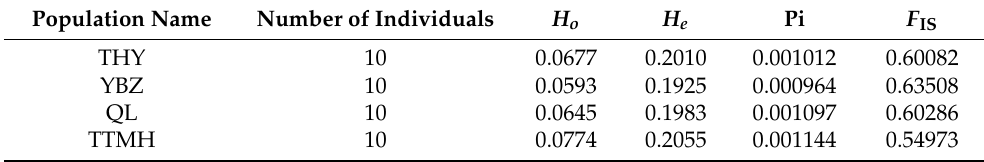
Table 2. The statistical values of genetic diversity among different clusters of H. leucisculus .